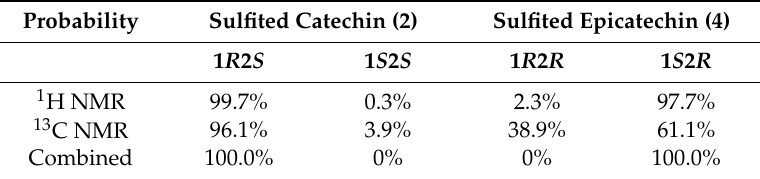
Figure 5. Absolute configurations of sulfited catechin ( 2 ) and sulfited epicatechin ( 4 ). Table 1. DP4 probability results for products 2 and 4